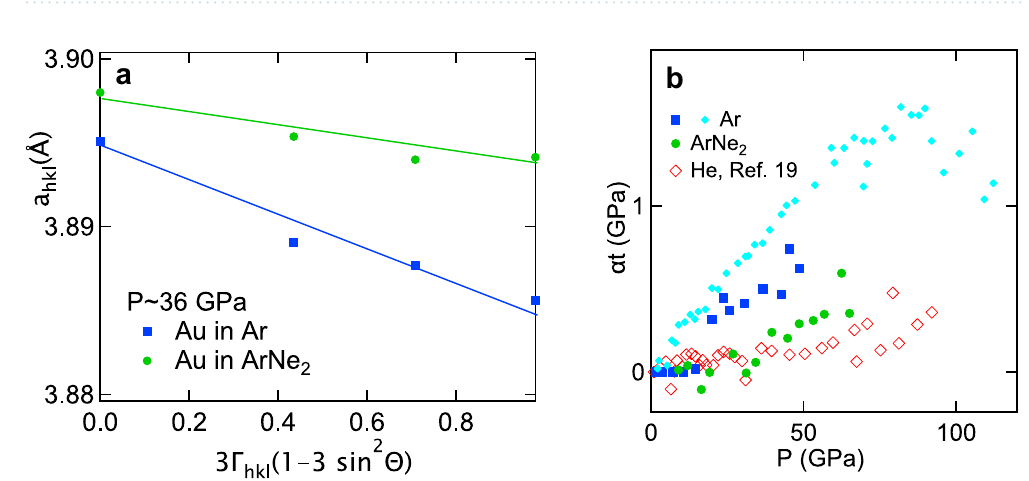
Figure 6. Evaluation of non-hydrostatic stress in runs 1 and 2 based on Au X-ray diffraction lines position. ( a ) Gamma plot for Au around 36 GPa. In this plot and underlying model, the slope of a hkl vs